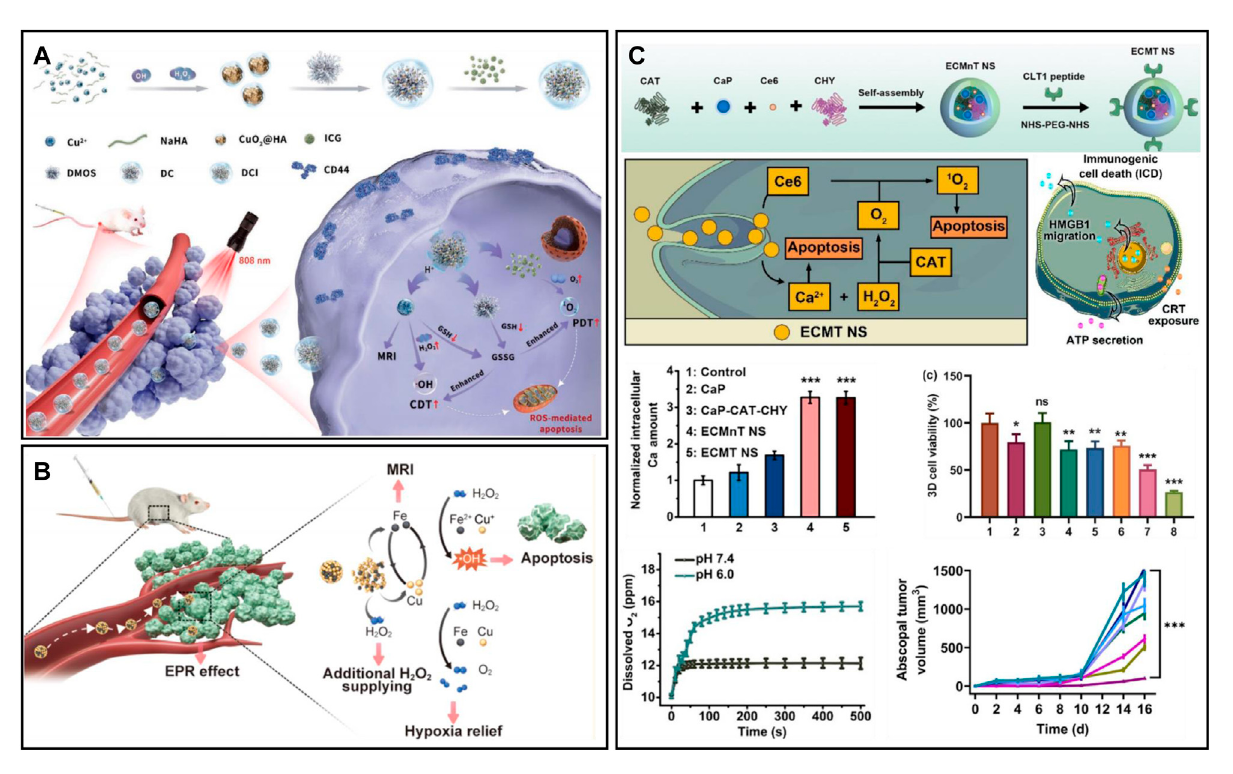
FIGURE 10 (A) DMOS@CuO 2 /ICG-HA for synergistic therapy. Reproduced from ref. (Zheng et al., 2018) with permission from Wiley, copyright 2022. Copper − ironperoxidenanoparticlesfortheFentonreaction.Reproducedfromref.(Wangetal.,2022d)withpermissionfromACSPublications,copyright 2022. (C) ECMT NS for tumor matrix destruction and cocktail therapy. Reproduced from ref. (Koo et al., 2022) with permission from Elsevier, copyright